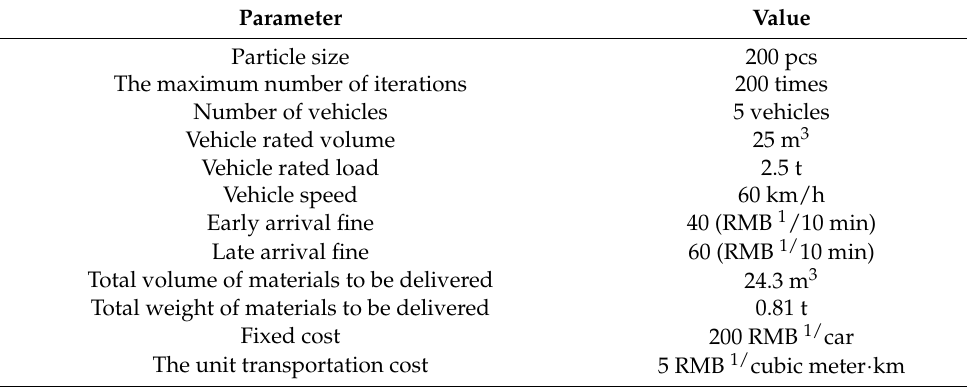
Table 8. Simulation